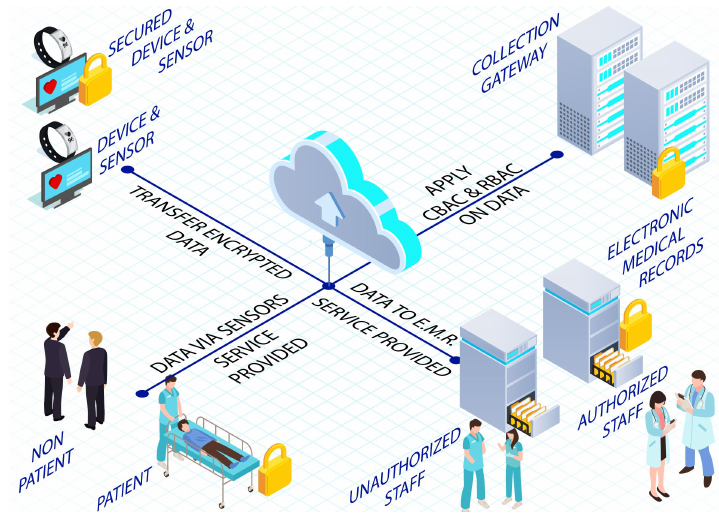
Figure 7. Service-oriented security framework in the IoT, proposed in [109].